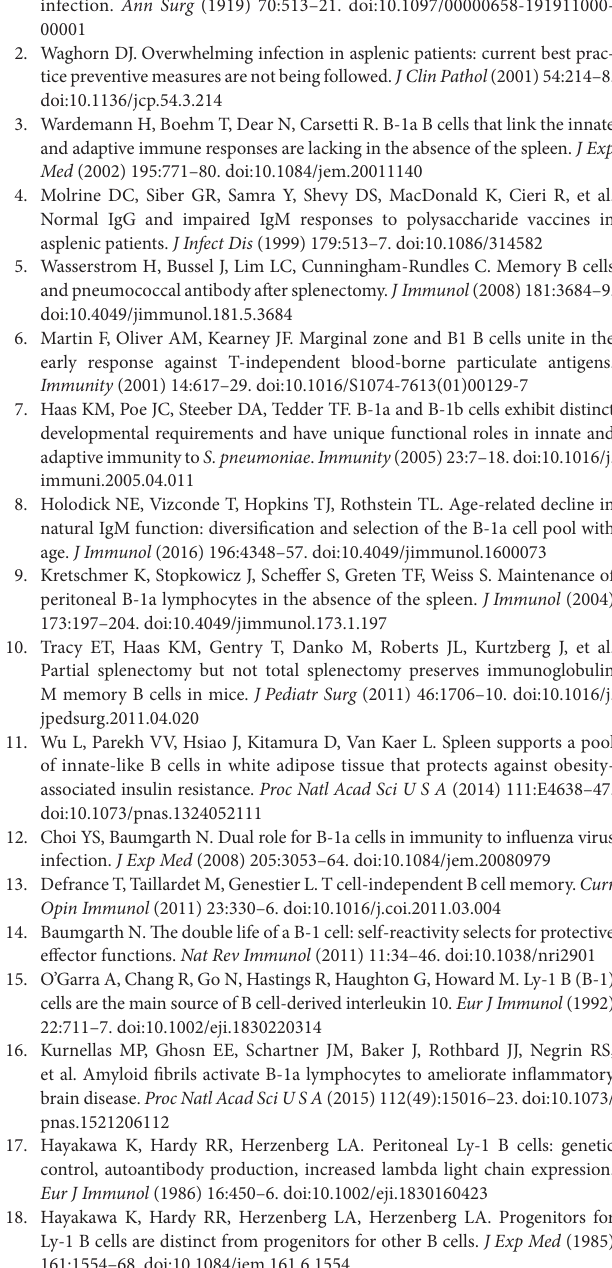
(c) Frequency of the indicated B cell subsets in the peritoneal cavity of recipient mice as gated from IgM + (donor-derived cells). (D) Representative plots and frequencies of bone marrow B-1a and B-2 cells after transfer of E11 cells into splenectomized versus sham-operated recipients. Plots were gated from IgM + cells (donor-derived cells). (e) Total IgM antibody levels at 6 weeks post fetal liver cell transfer. Sera were run in threefold dilution with a starting dilution of 1:10 and statistics calculated by comparing area under the curve. The experiment was performed once. Statistically significant differences are indicated by * denoting p < 0.05 by unpaired